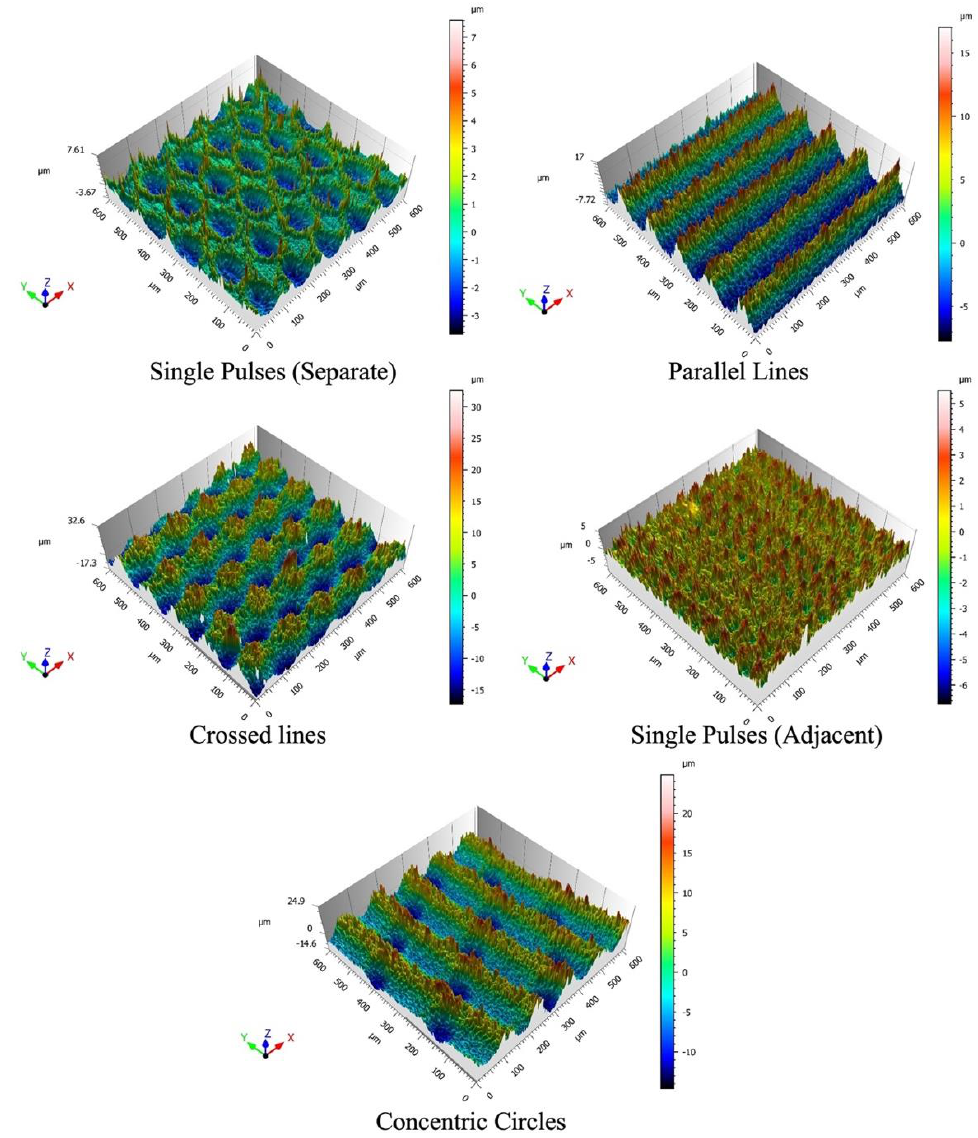
Figure 9. Three-dimensional topography maps of Surf 1 samples (laser texturing + sol–gel (TEOS)) for all scanning strategies and an average laser power of 17 W.